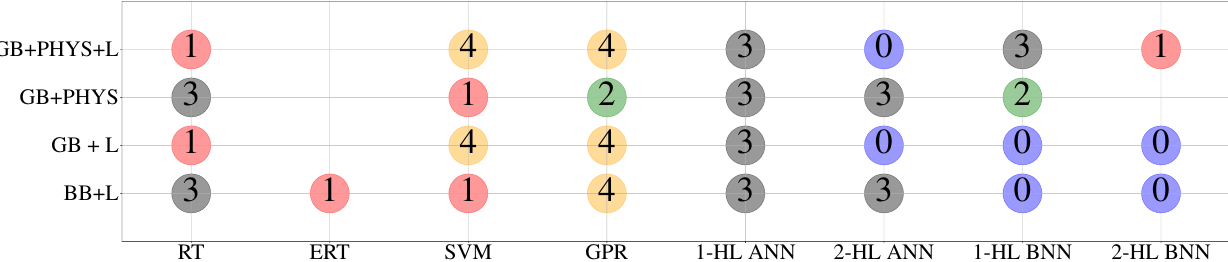
Figure 10. Second filter clustering of models using K-means algorithm. The assigned number for each colour is